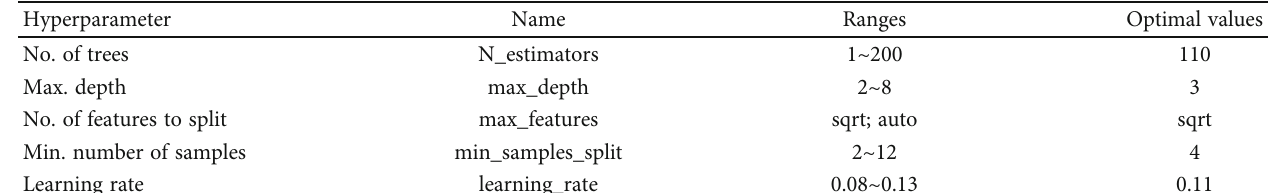
Table 3: Optimal hyperparameter values of the